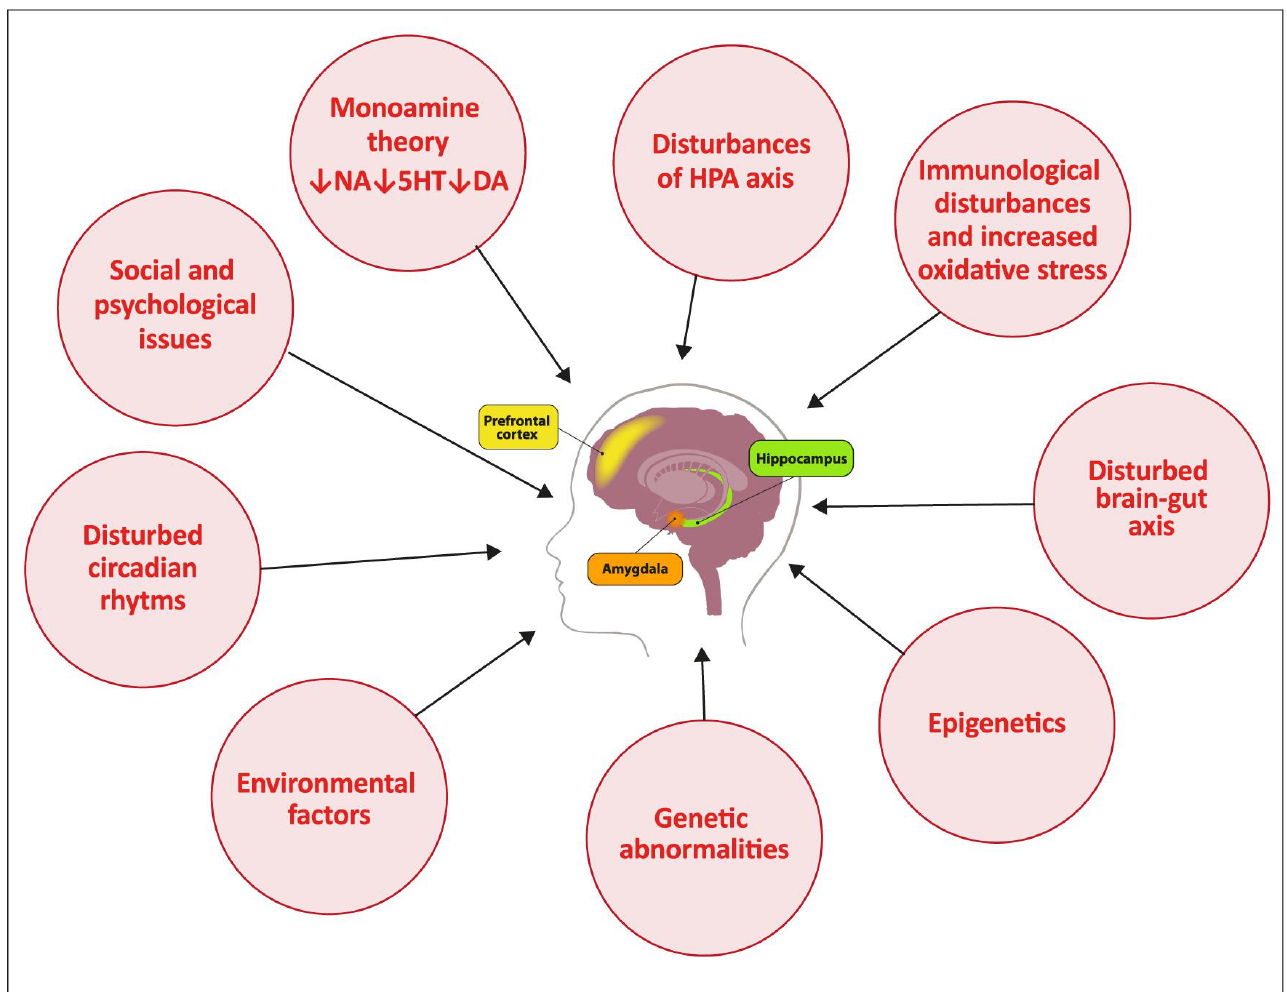
Figure 1. The main pathomechanisms of depression. The main structures associated with the path- ogenesis of depression are the prefrontal cortex and the limbic system (including the hippocampus and the amygdala). According to the comprehensive, psycho-neuro-immuno-endocrinological the- ory of the development of depression, this disease results from the action of multiple exogenous and endogenous factors. Details are given in the text. (HPA – hypothalamic-pituitary-adrenal axis; 5HT – 5-hydroxytryptamine; serotonin; NA – noradrenaline; DA – dopamine).